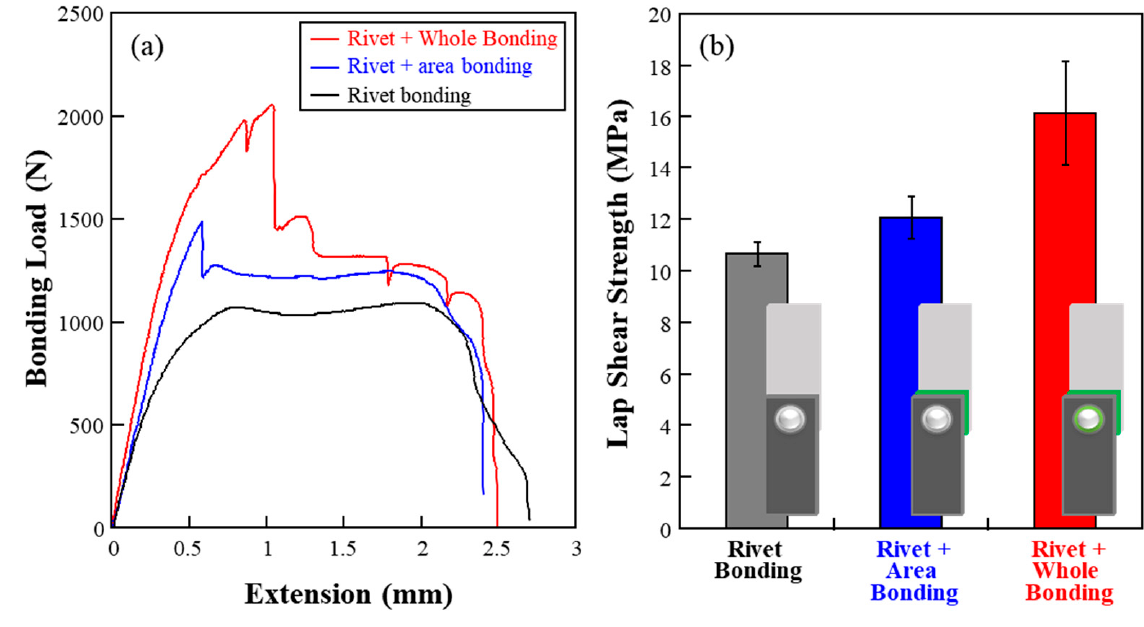
Figure 3. LSS results of CFRP/steel composites using riveting: ( a ) Load-extension graph and ( b ) LSS results in each case.